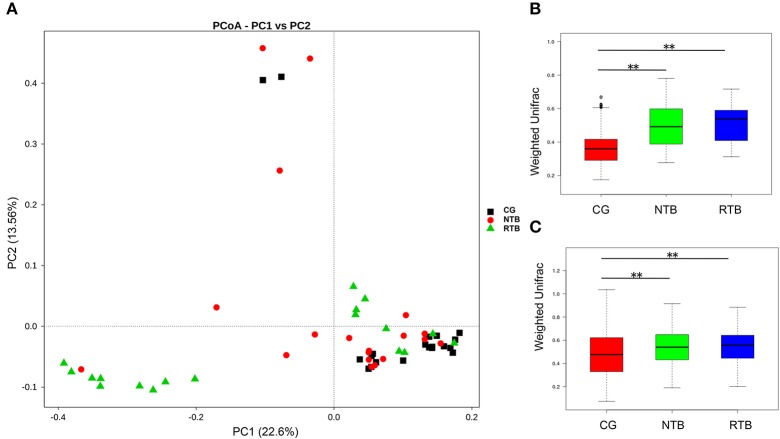
The beta-diversity of the microbial communities in the new and recurrent tuberculosis patients and the healthy control. (A) Principal Coordinates Analysis (PCoA) plot based on unweighted UniFrac distance. Each dot represents one sample from each group. (B) Beta-diversity index difference based on unweighted UniFrac. (C) Beta-diversity index difference based on weighted UniFrac. The p-values were calculated using Wilcox test. Statistical significance is displayed as **p < 0.01.